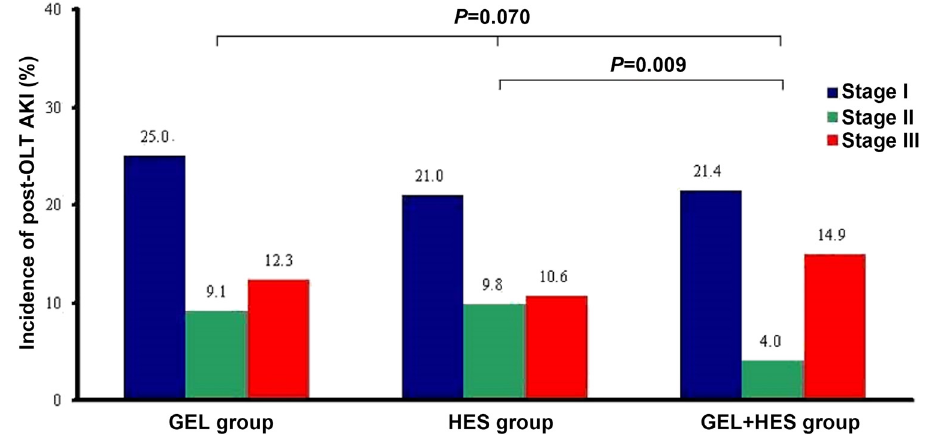
Figure 3: Incidence and stages of post - OLT AKI in di ff erent